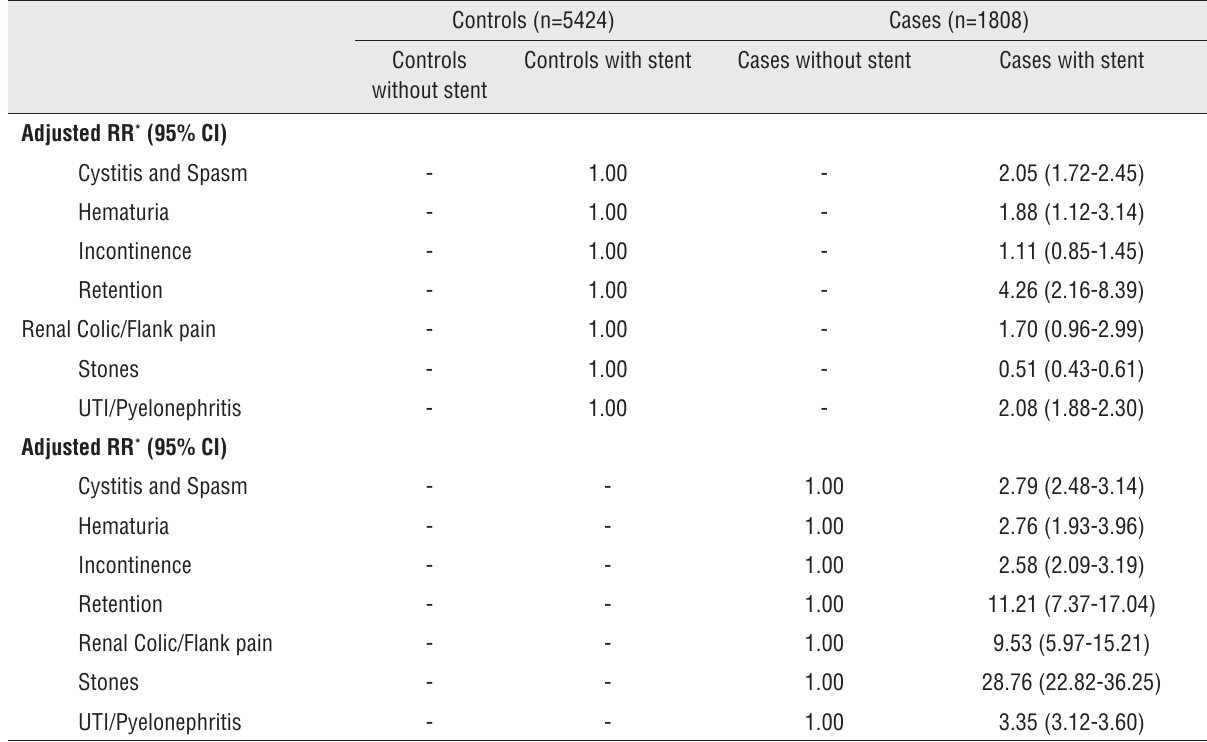
Table 4 - Rate ratios of UAE among cervical cancer cases and